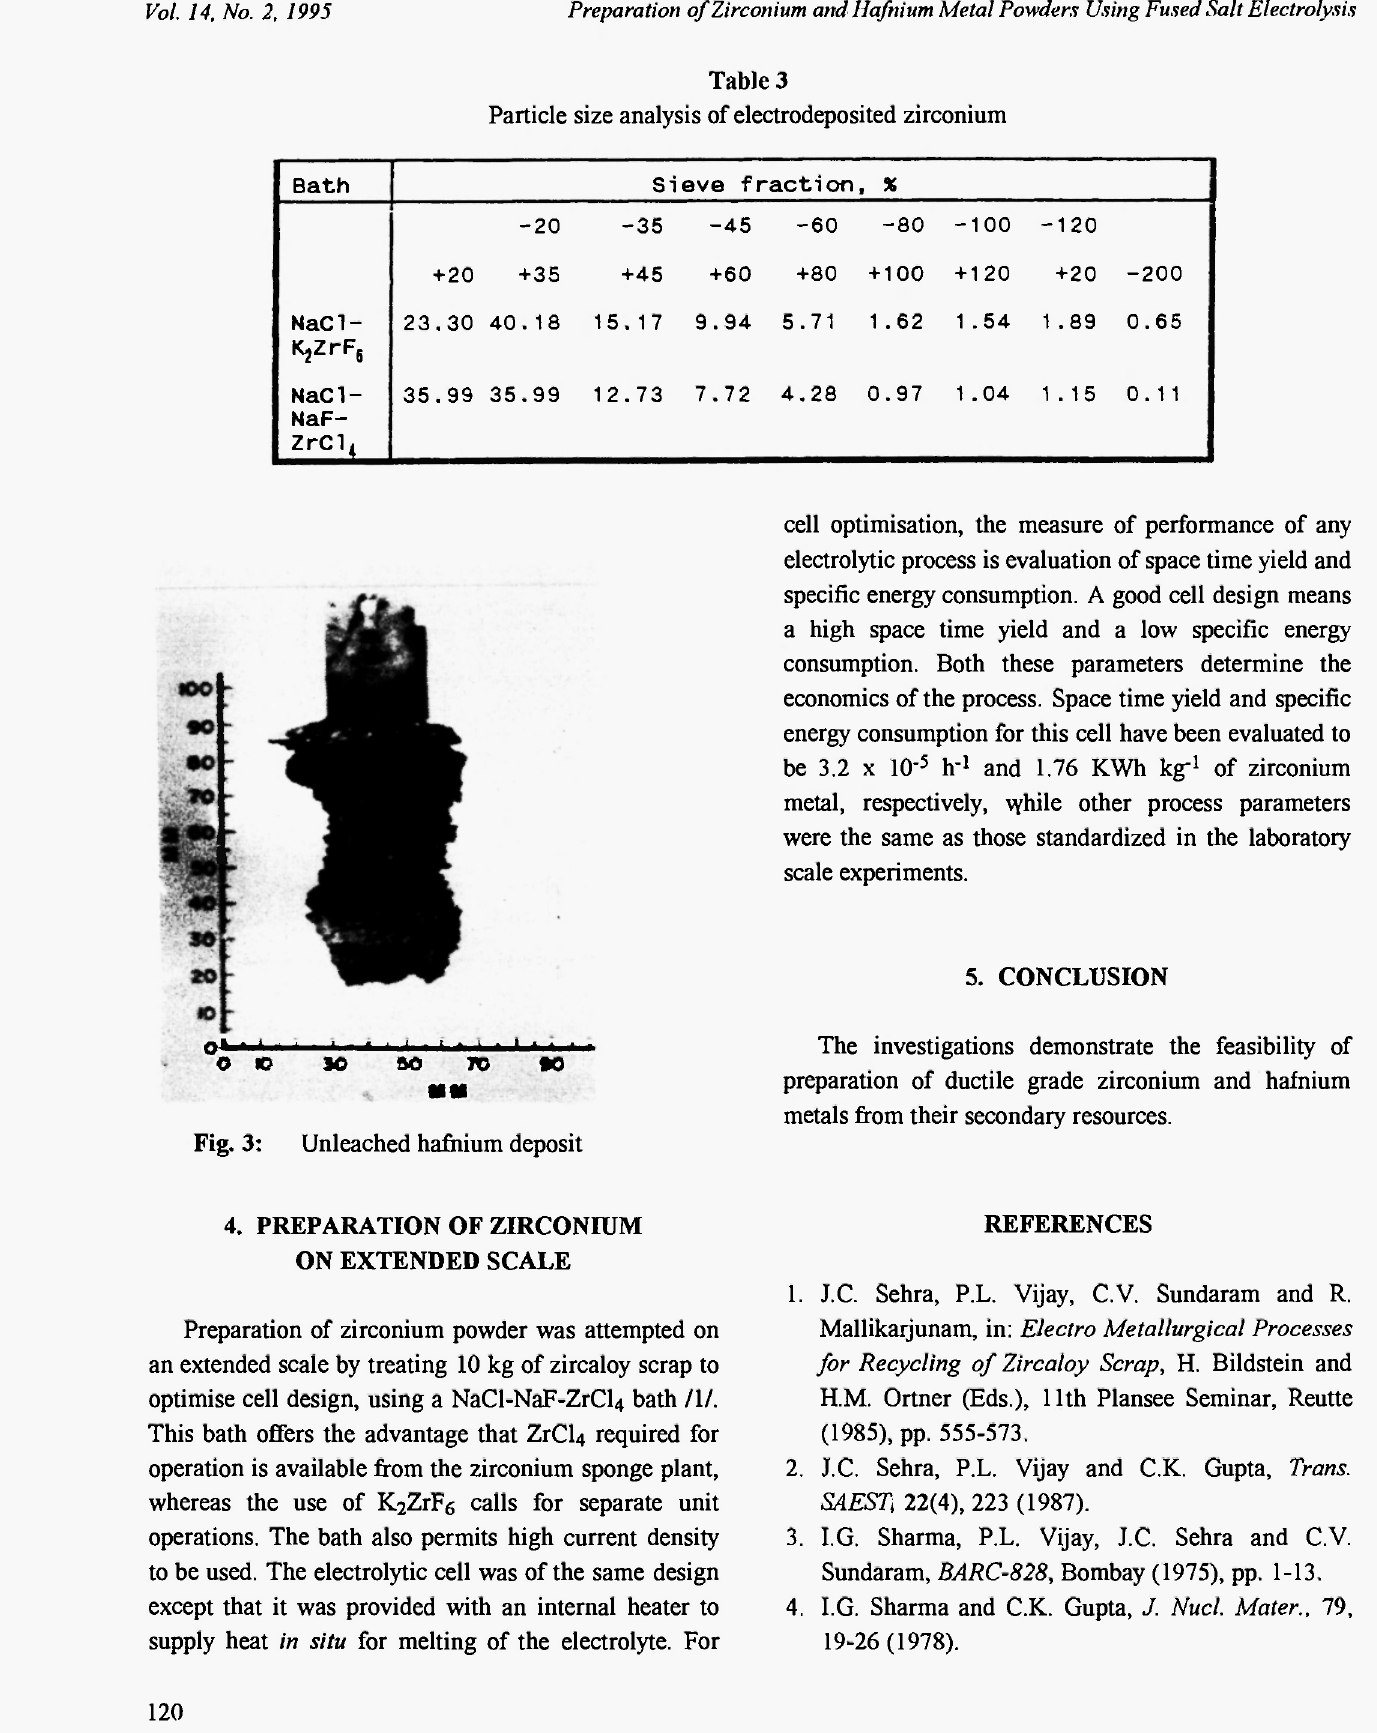
Unleached hafnium